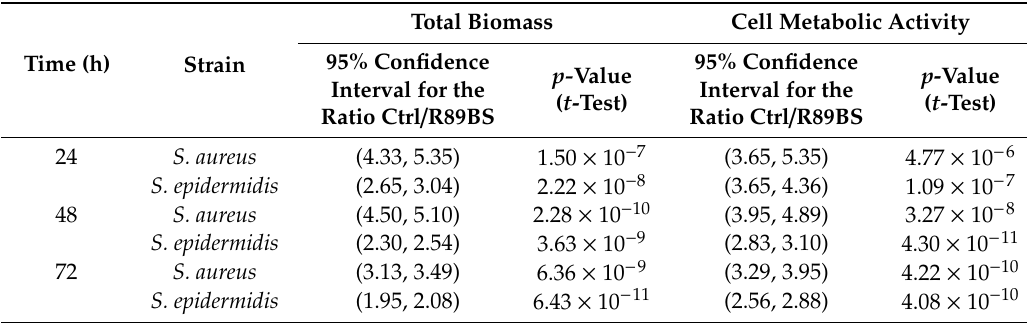
Table 2. The 95% confidence intervals and p -values calculated for Staphylococcus spp. biofilm total biomass and cell metabolic activity in pre-coating assays. Ctrl—control.